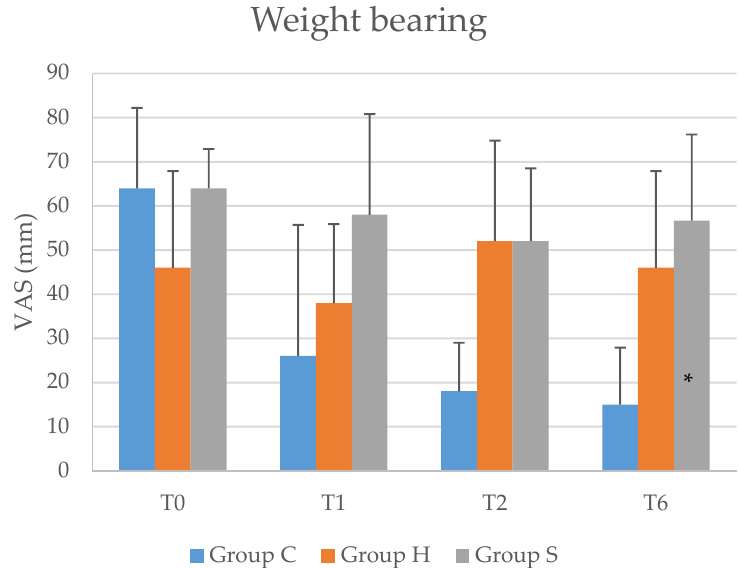
Figure 2. Mean differences from baseline in the VAS score under weight-bearing with the 95% confidence interval ( t -test). VAS = visual analog scale; T0 = before injection; T1 = 1 week after the start of the protocol; T2 = 2 weeks after the start of the protocol; T6 = 6 weeks after the start of the protocol. Group C indicates the group of patients treated with polynucleotide sodium. Group H indicates the group of patients treated with sodium hyaluronate. Group S indicates the group of patients treated with crosslinked sodium hyaluronate. The p values are based on the results of one-way ANOVA comparing Diff (T6–T0) among the groups; * p < 0.05.